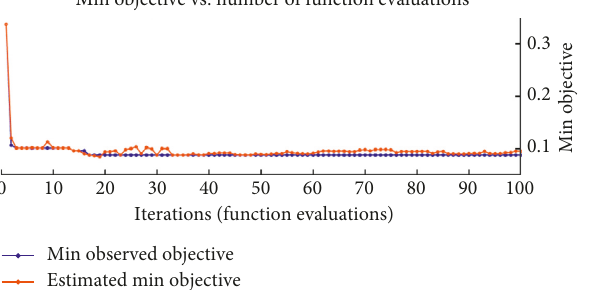
Figure 6: Evolution of minimum observed objective and estimated minimum objective in total 100 iterations, where the minimum calculated value is